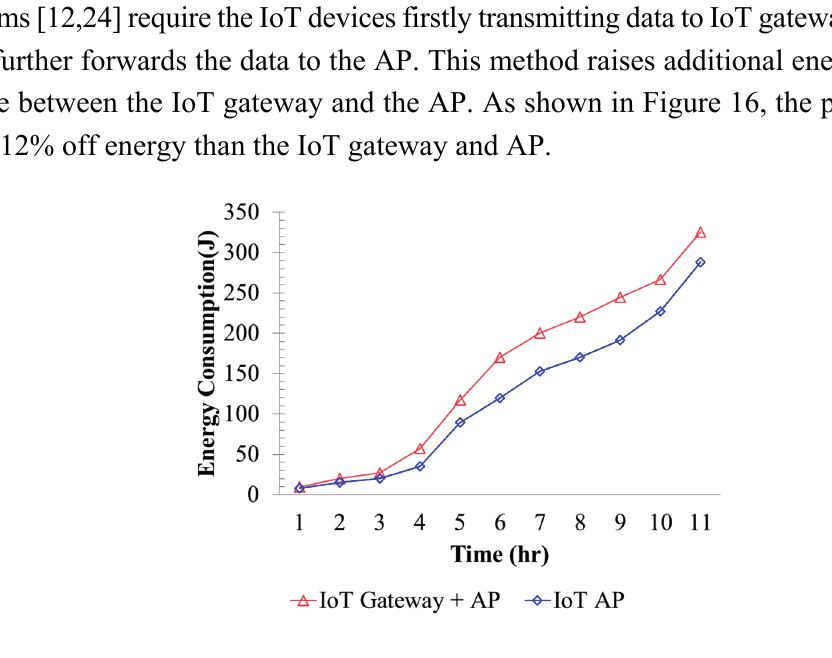
Figure 16. Comparison of energy